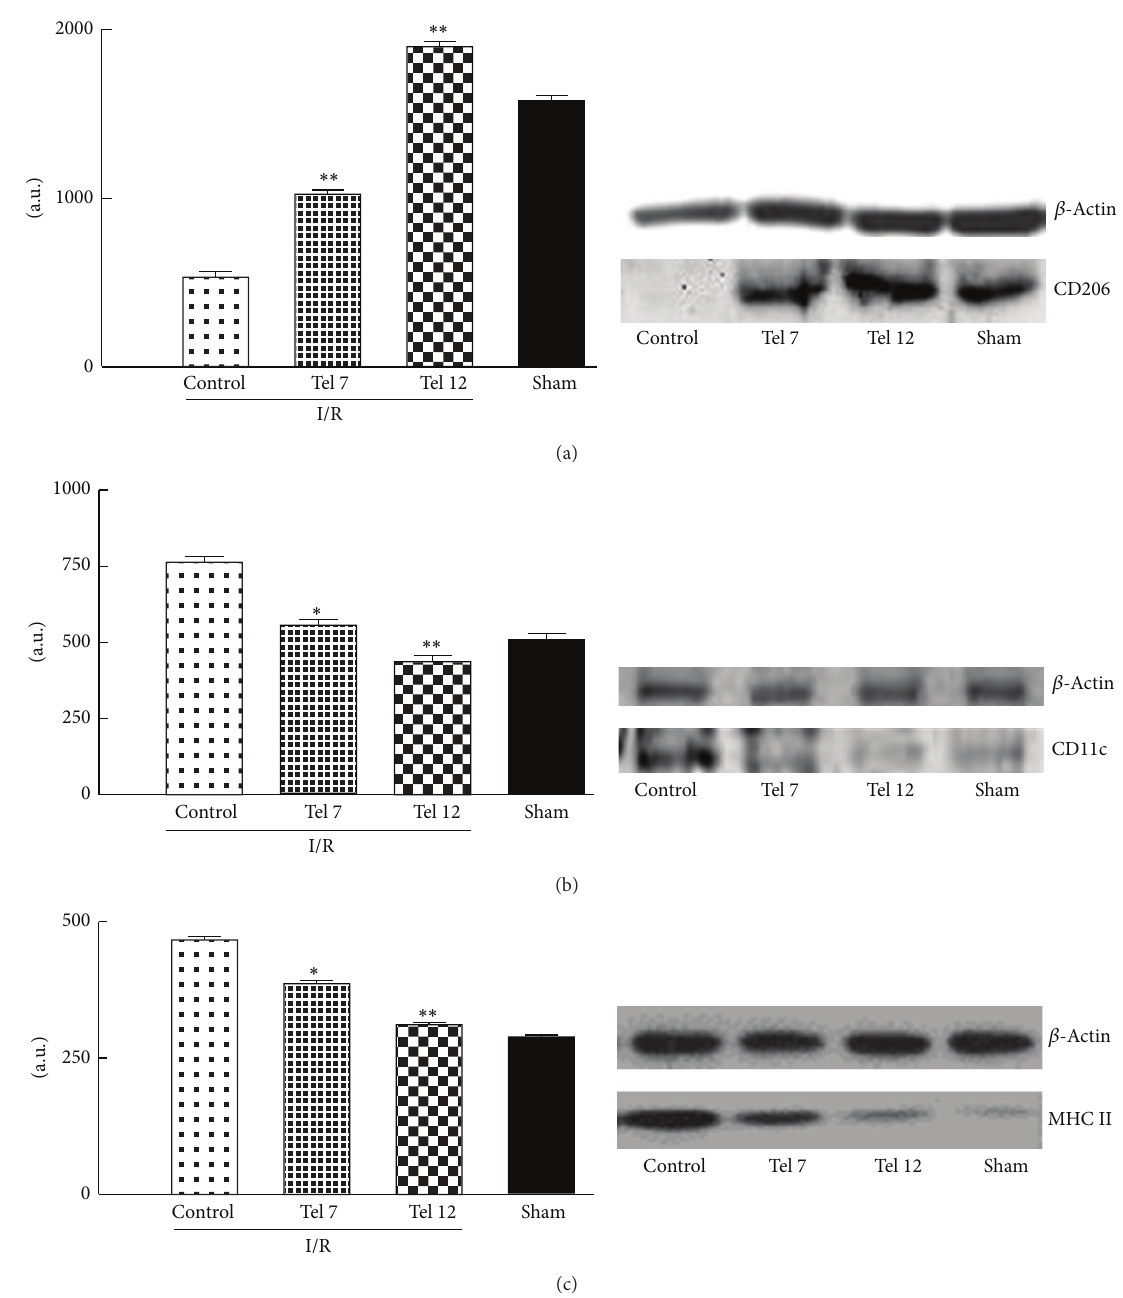
Figure 4: Immunoblotting for the macrophages CD206, CD11c, and MHCII in cardiac tissue of ZDF rats. (a) Expression of mannose receptor (CD206) characterizing M2 macrophage phenotype. (b, c) Expression of Integrin Alpha X/CD11cand of the major histocompatibility